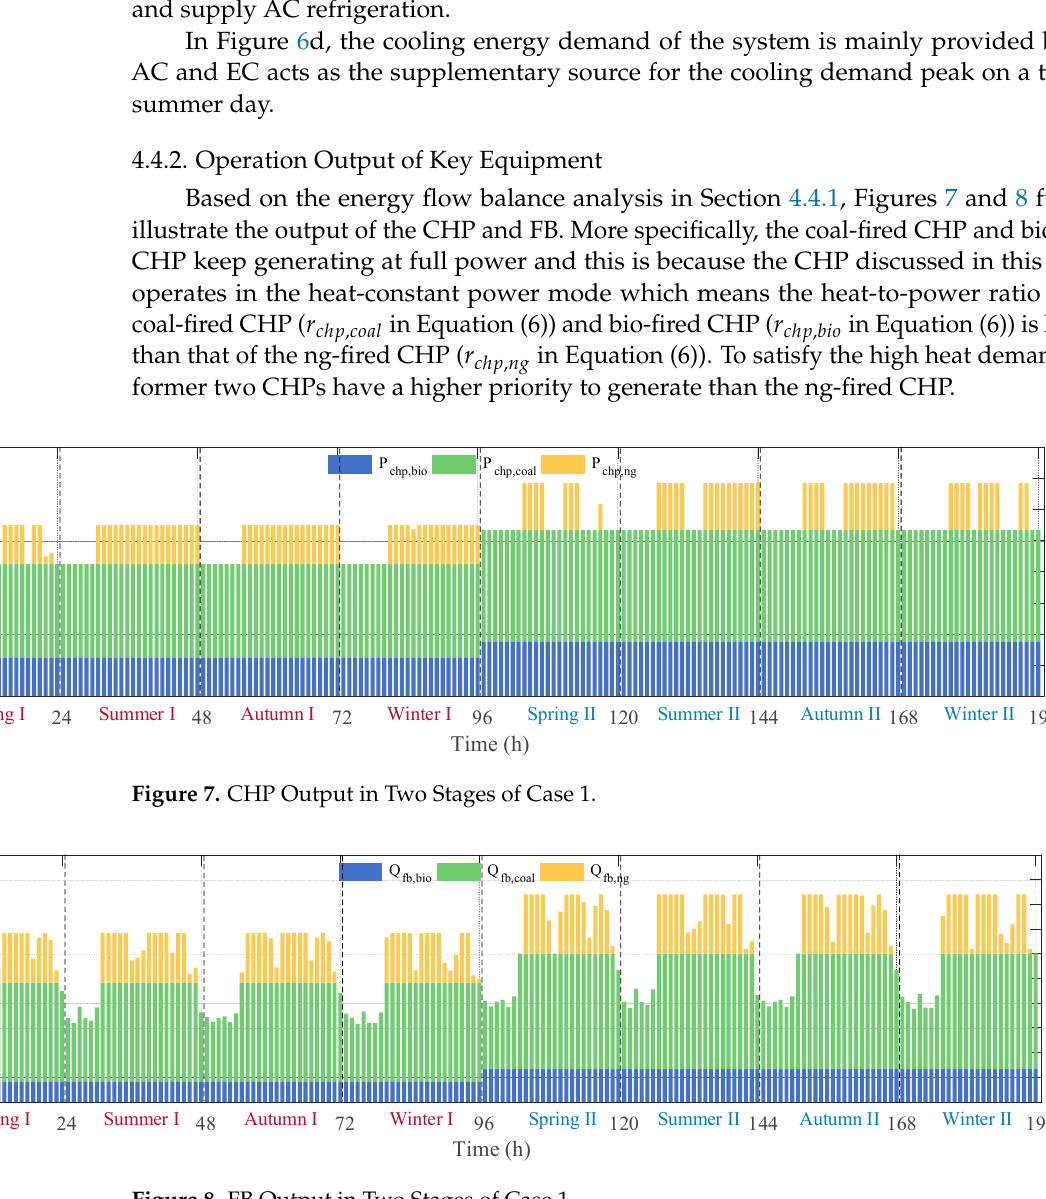
Figure 8. FB Output in Two Stages of Case 1.